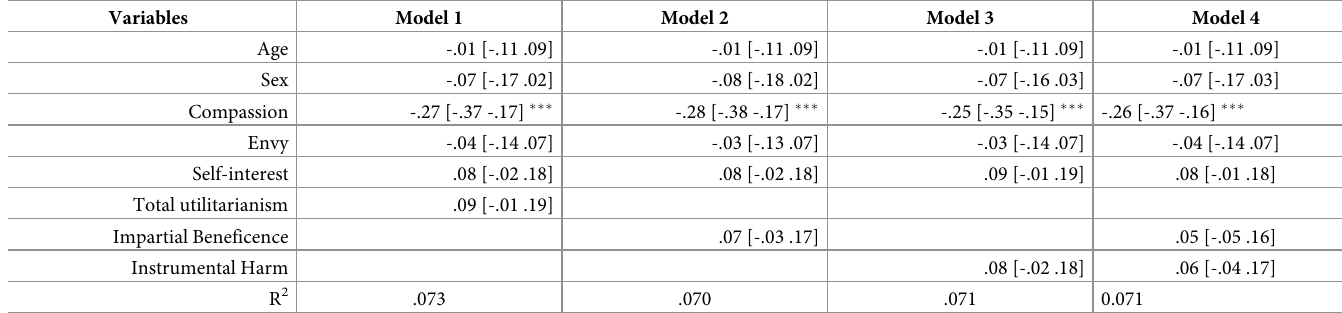
Table 4. Regression models predicting scores of the mutualism